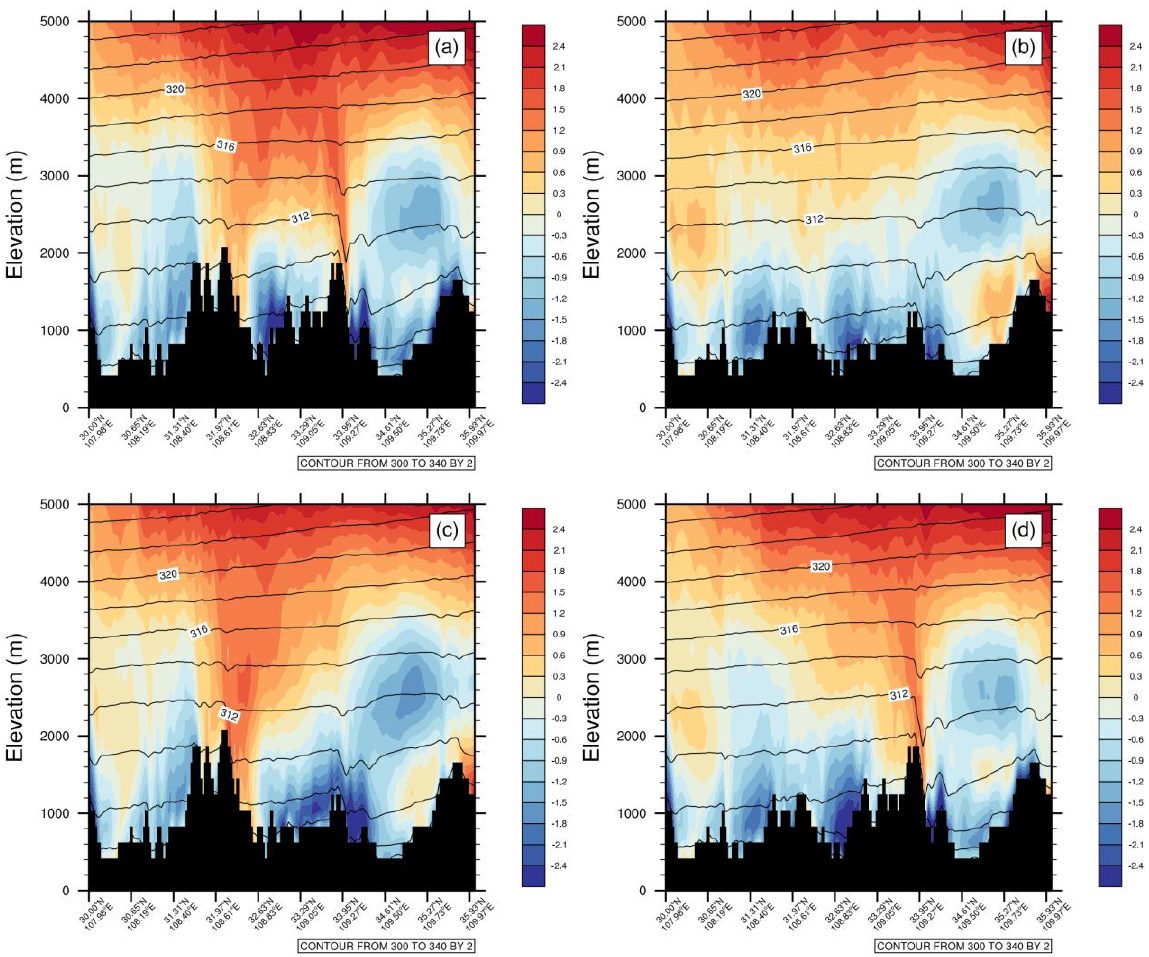
Figure 14. Vertical cross sections of vertical velocity of wind (m s −1 , color filling) and potential temperature (K, contour line) along the blue lines in Figure 1 of ( a ) CTRL, ( b ) LowQD, ( c ) LowQ, and ( d ) LowD on an average on 17:00 UTC (local time of 00:00, midnight) during the whole simulated time period.